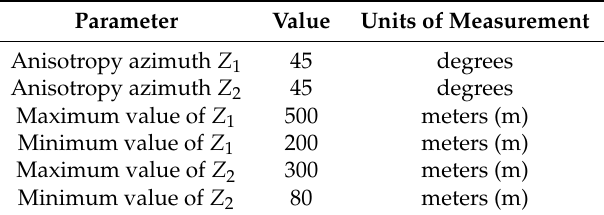
Table 2. Structural parameters of Z 1 and Z 2 .